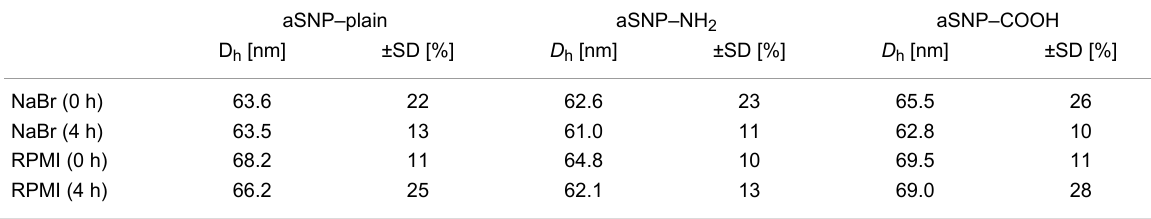
Table 1: Hydrodynamic particle diameters ( D h ) were measured in cell culture medium (RPMI 1640) and, for reference, in water (containing 2 mmol/L sodium bromide to guarantee optimum colloidal stability). Two time points were chosen: 0 and 4 h, representing the starting and end point of particle